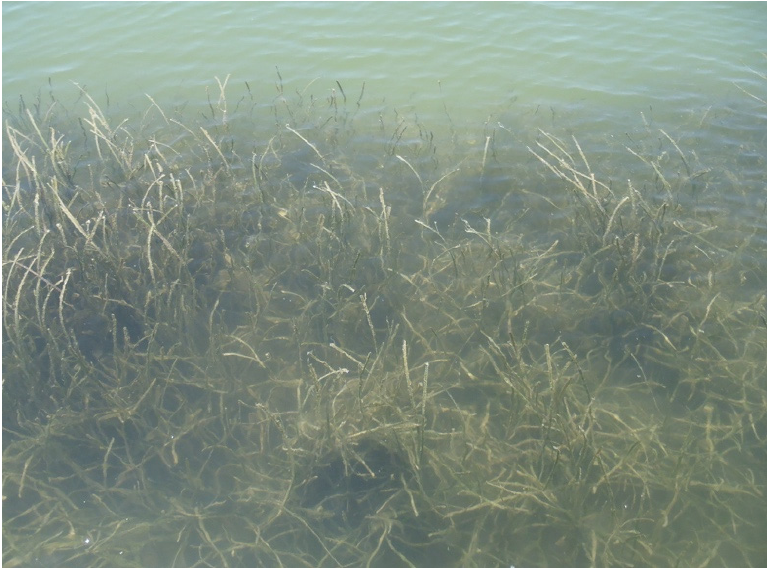
Figure 13. The seagrasses meadows with Cymodocea nodosa covering the substrate of the lagoon.